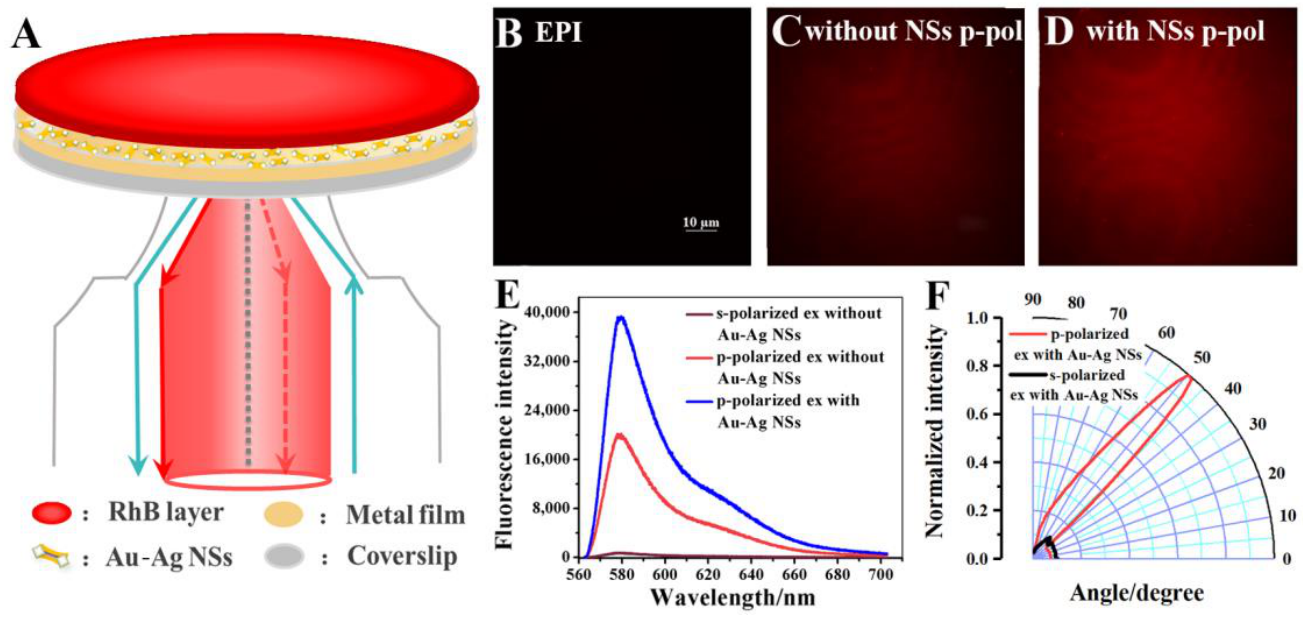
Figure 1. ( A ) The schematic for the Au-Ag NS enhanced RhB-PMMA fluorophore layer imaging. ( B ) The EPI image of fluorophore layer. The images of fluorophore layer ( C ) without and ( D ) with Au-Ag NSs modification excited by p-polarized incident light. ( E ) The SPCE spectra of the fluoro- phore layer without and with Au-Ag NSs enhancement. ( F ) The excitation angular distribution of the fluorophore layer with Au-Ag NSs